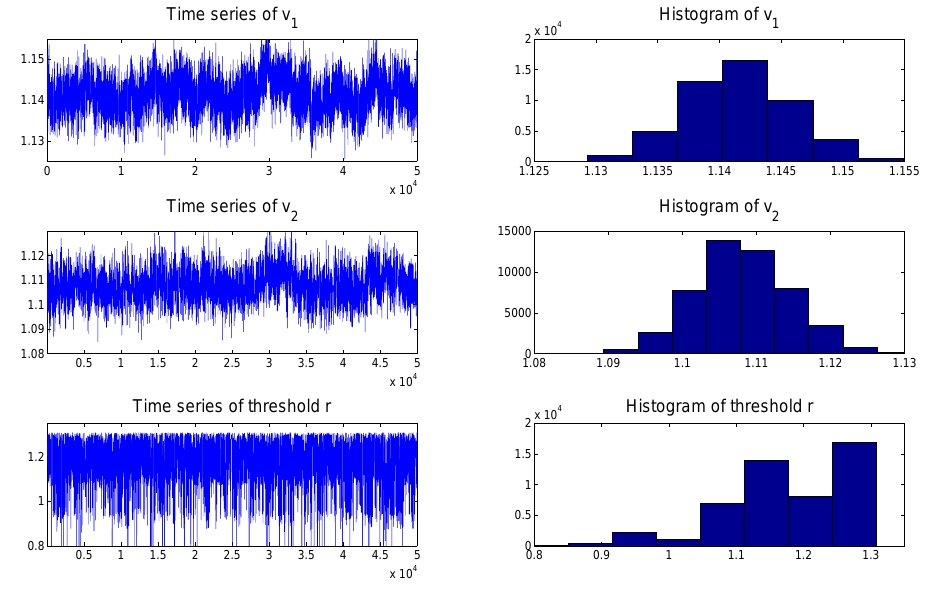
Figure 8. Time series and histograms of the samples drawn from the full conditionals of the parameters of the TSCD-W model based on the Boeing duration